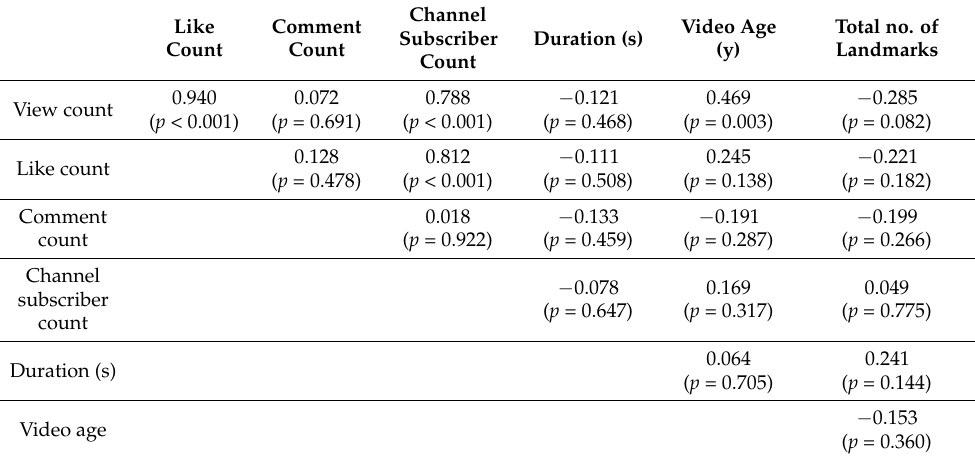
Table 5. Pearson correlation between the viewing metrics.